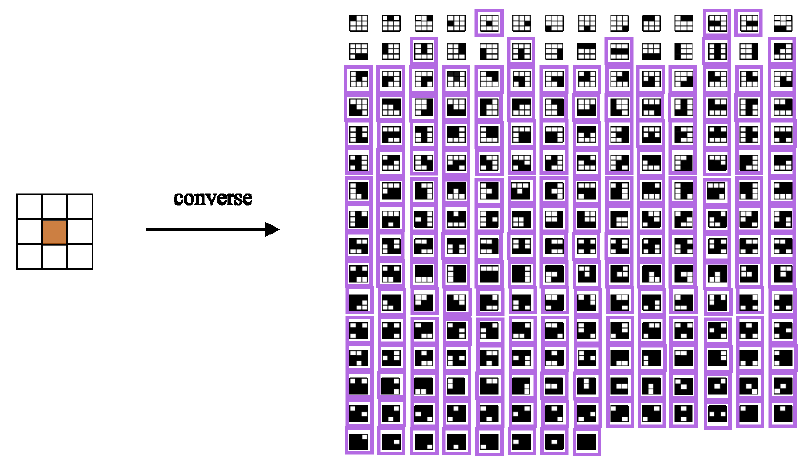
Figure 3: The converse relation of the minimum bounding rectangle tile in the direction relation matrix. The result has a high degree of uncertainty, causing potential errors in spatial reasoning applications where the direction relation is stored only in that order